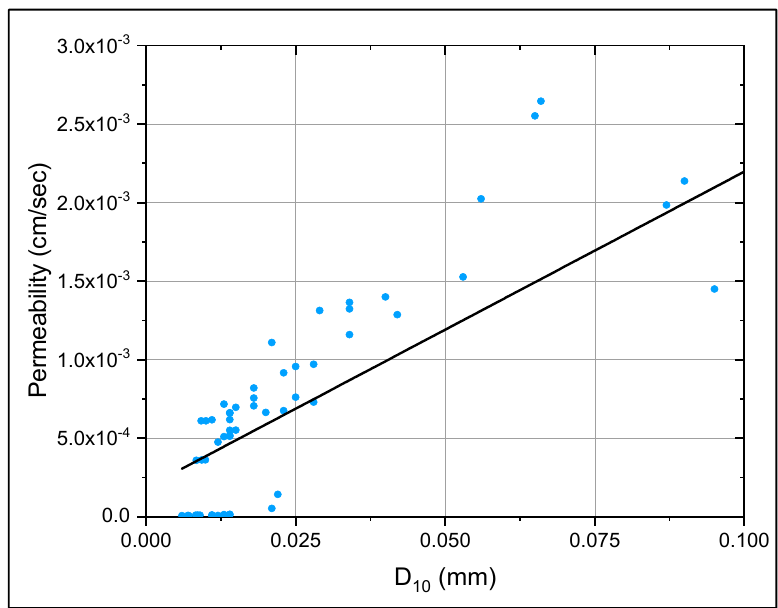
Figure 6. Permeability versus maximum dry density.